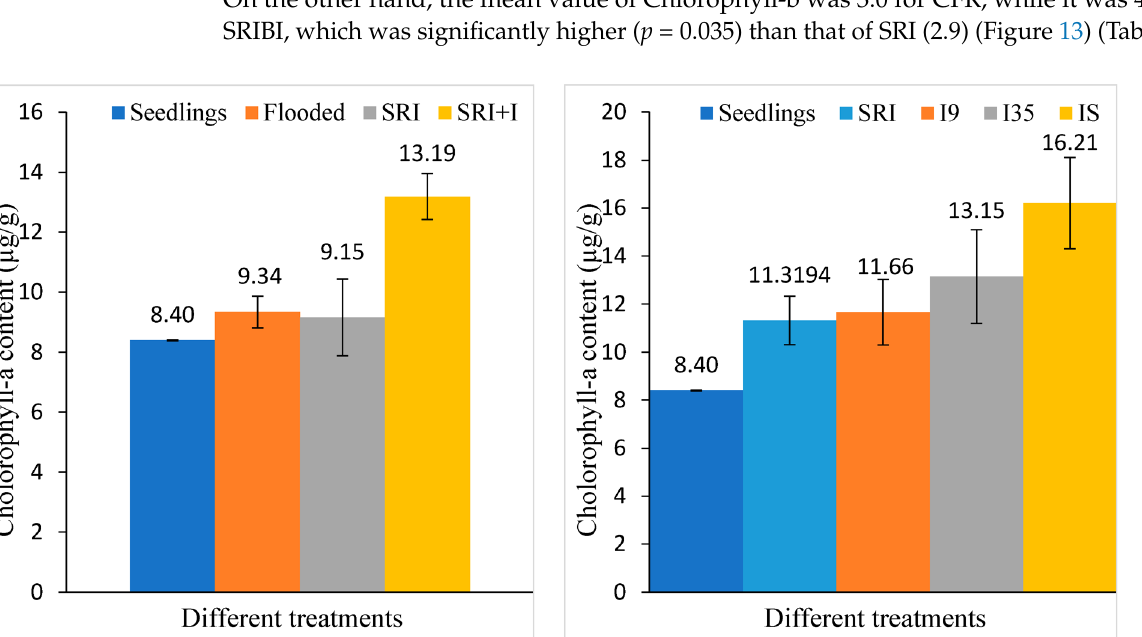
Figure 13. Comparison of chlorophyll-b content between the different treatments ( Left : 2017; Right : 2018). Table 11. Parameters from ANOVA statistical analysis for chlorophyll content comparison. Chlorophyll content